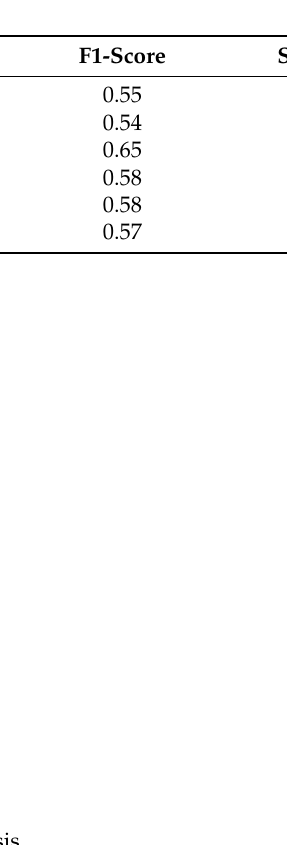
Table 3. TextBlob classification_report.